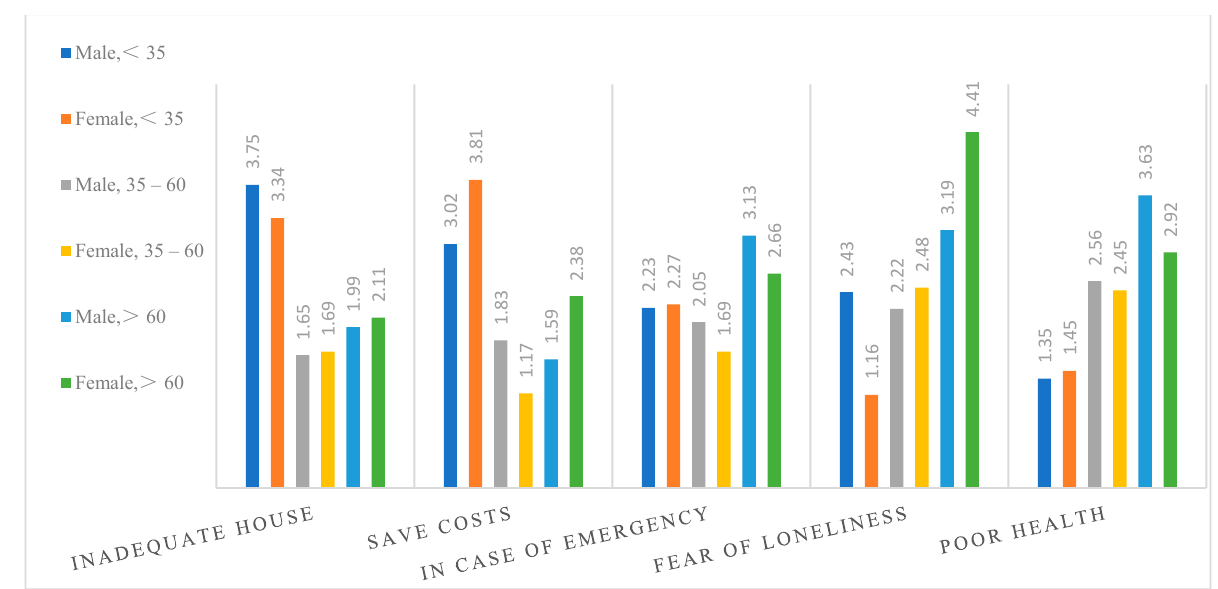
Figure 5. Intergenerational factors in groups of all genders and ages.